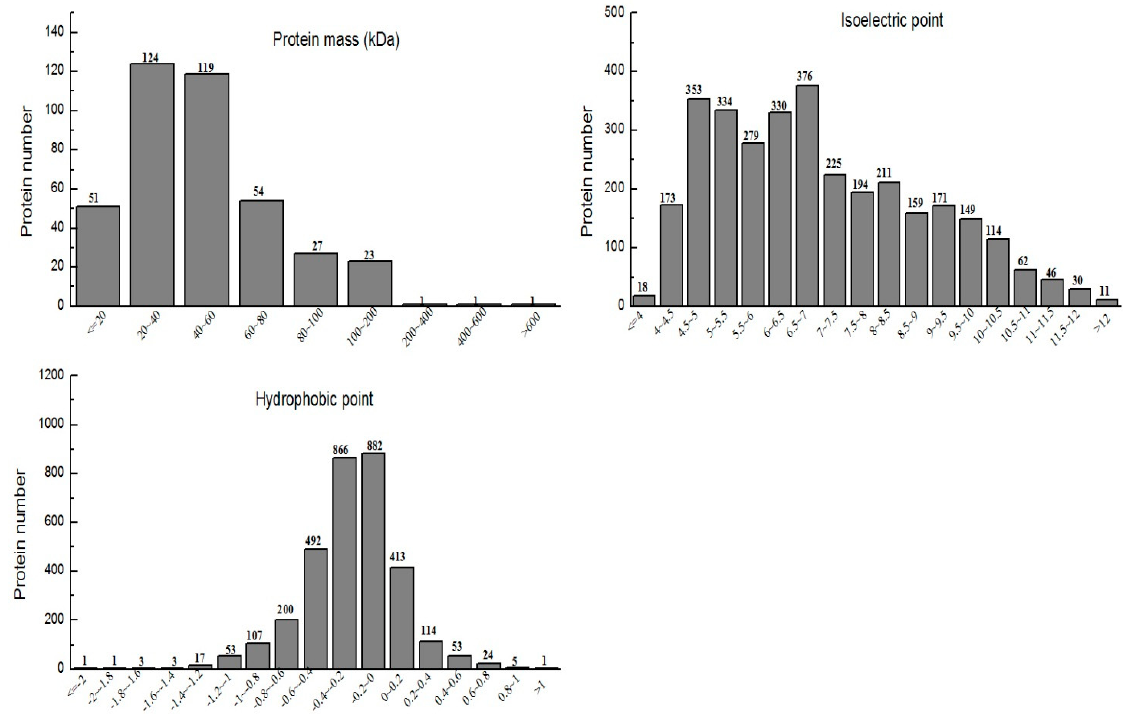
Figure 1. Protein mass distribution, isoelectric point distribution, and hydrophobic property analysis of identified proteins.